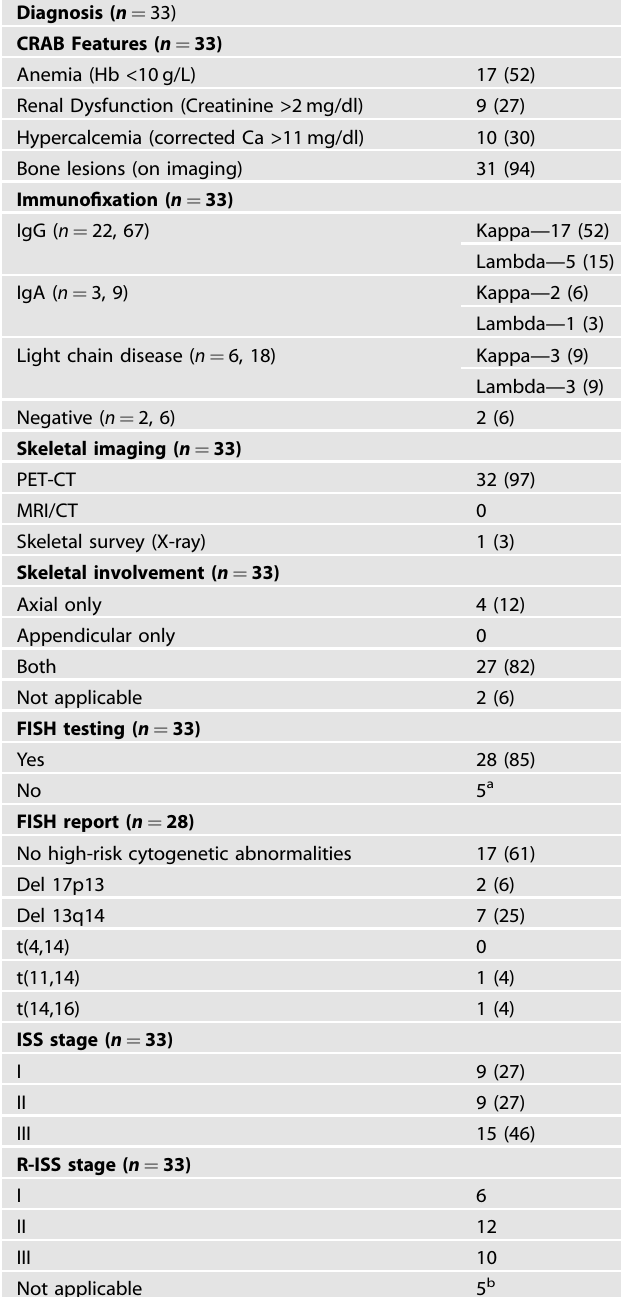
Table 2. Disease characteristics of the study patients ( N =